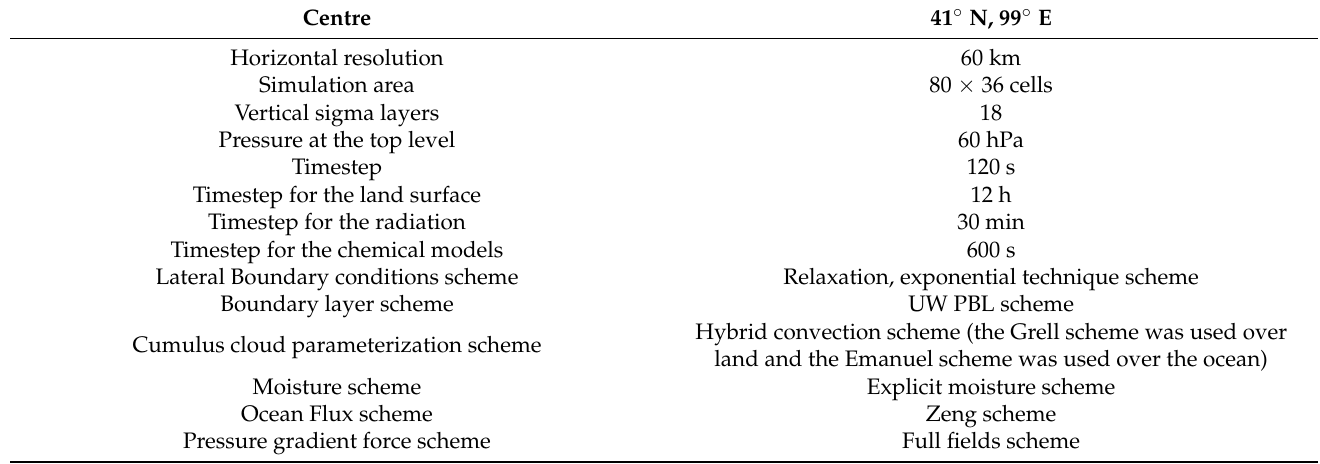
Table 1. Parameter settings of RegCM.